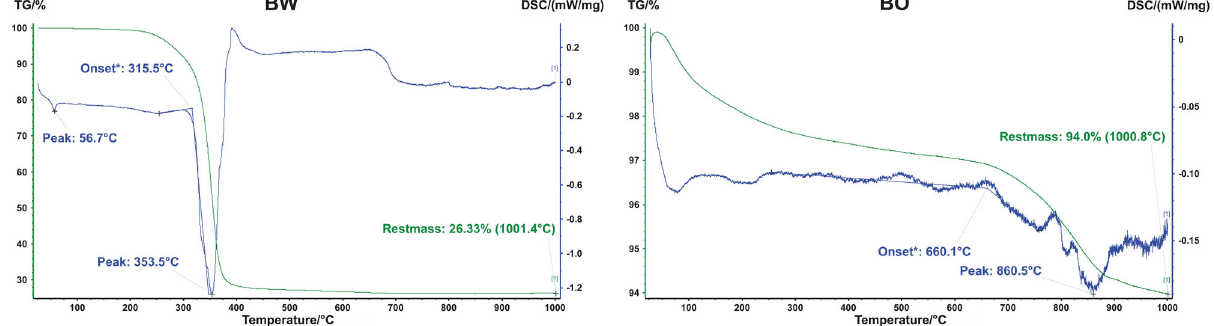
Fig. 1 Thermogravimetric Analysis (TGA, green) and Differential Scanning Calorimetry (DSC, blue): TGA mass loss onset and DSC peaks for bone graft materials BW (left) and BO